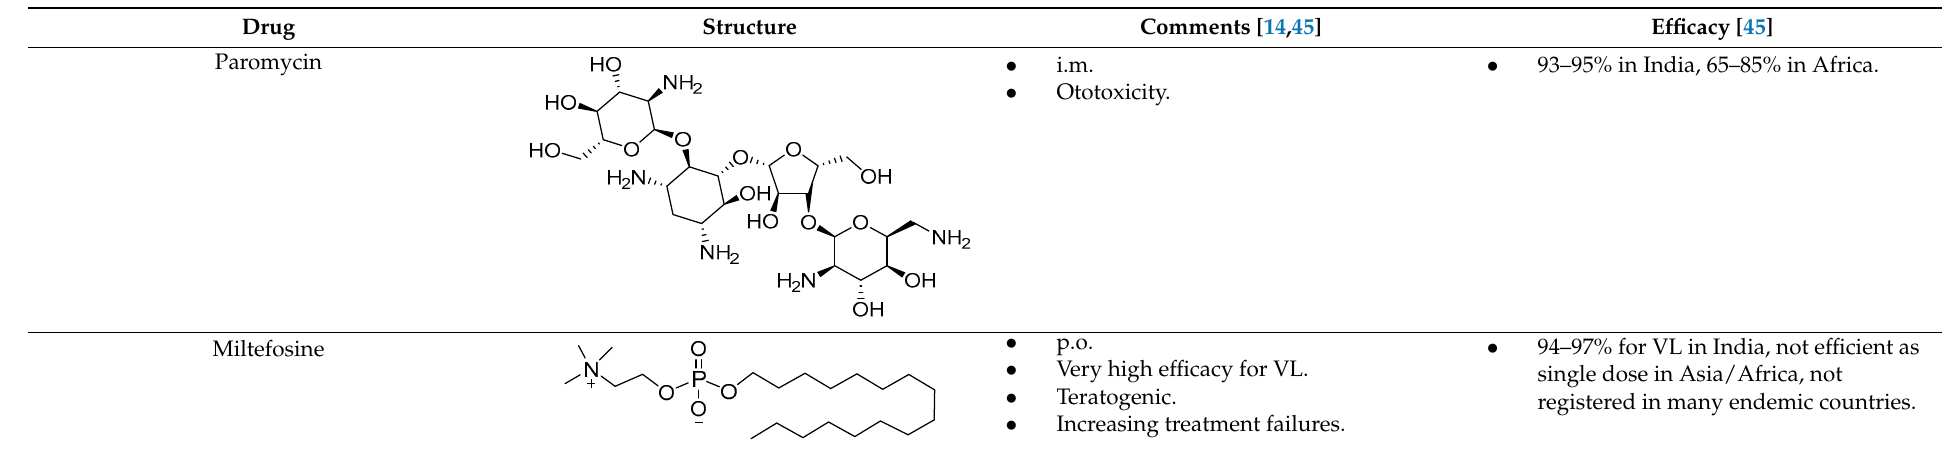
Very high efficacy for VL. Teratogenic. • Increasing treatment failures.